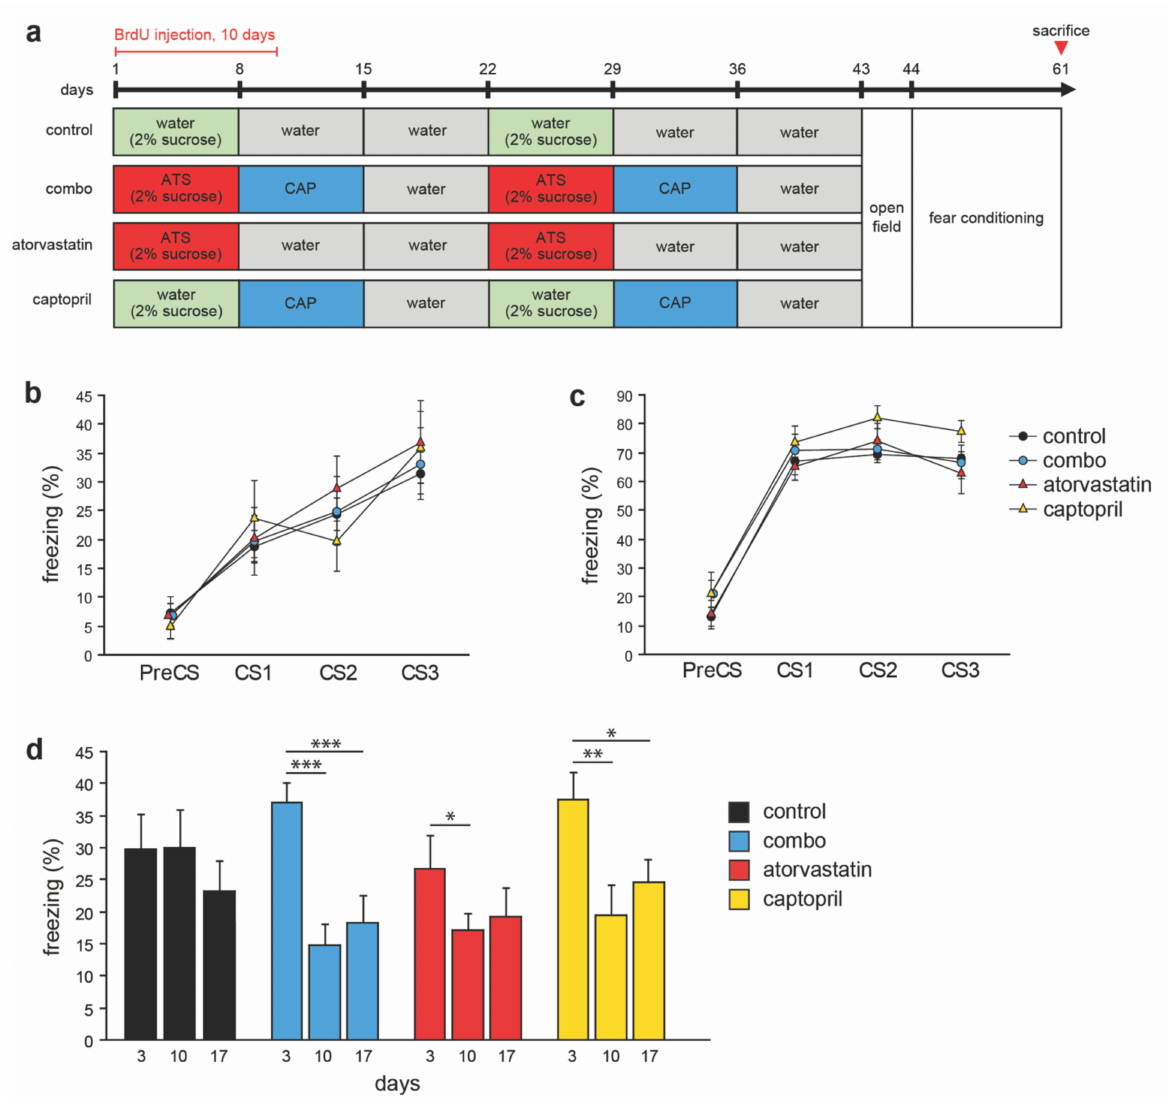
Figure 4. Effects of compound treatment on contextual fear memory in adult mice. ( a ) Compound treatment and behavioral testing schedule of the adult mice. At the start of the experiment, each compound was administered to mice daily for a week at a time, for two cycles. Treatment lasted for a total of six weeks. ( b – d ) Contextual fear conditioning testing: following habituation and conditioning sessions on the first and second day, respectively, tone-cued memory retrieval was tested on day 3. On the same day, contextual fear memory in the original environment was examined. Subsequently, memory extinction was tested on day 10 and 17. ( b ) No significant difference between the groups was found in conditioning session (PreCS, CS1, CS2, and CS3) or in ( c ) the tone-cued memory retrieval session. ( d ) There was a significant interaction between groups in freezing time during the extinction trials. Post-hoc comparisons showed that the combo, captopril and atorvastatin groups, but not the control group showed extinction of fear over time. Atorvastatin, ATS; captopril, CAP; bromodeoxyuridine, BrdU. * p < 0.05, ** p < 0.01, *** p <